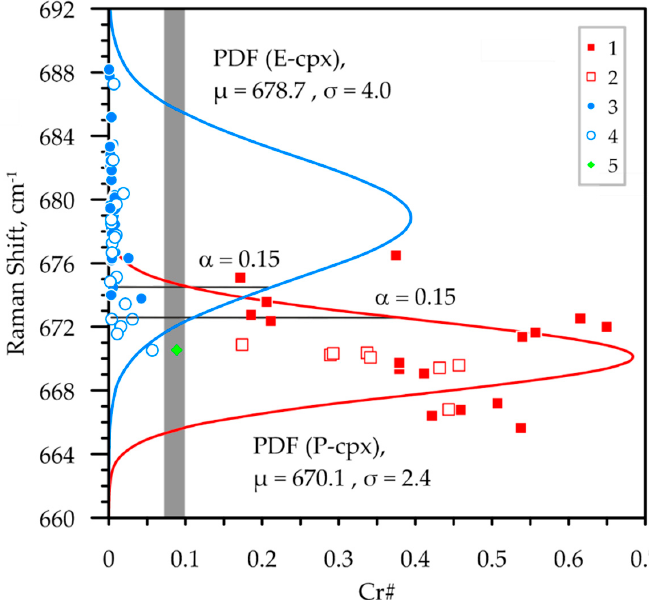
Figure 6. Raman shift of stretching mode ν 11 vs. Cr# of clinopyroxenes: 1—peridotite clinopyroxene inclusions in diamonds, 2—clinopyroxenes from peridotites, 3—eclogite clinopyroxene inclusions in diamonds, 4—clinopyroxenes from eclogites; 5—clinopyroxene inclusion in diamond with